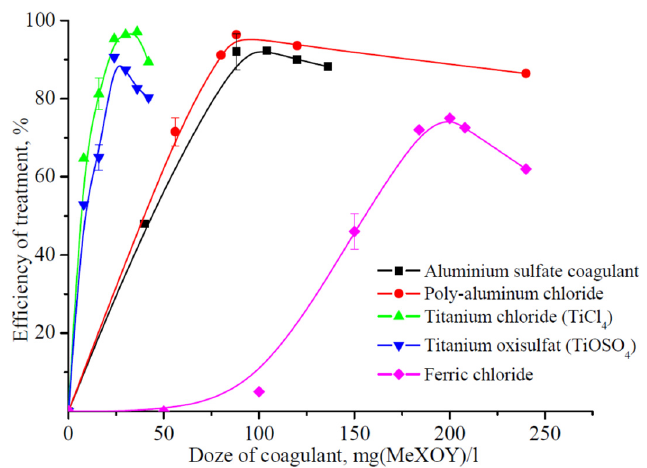
Figure 1. Dependence of the alcohol industry wastewater treatment efficiency from the suspended solids by various coagulants on the coagulant dose.